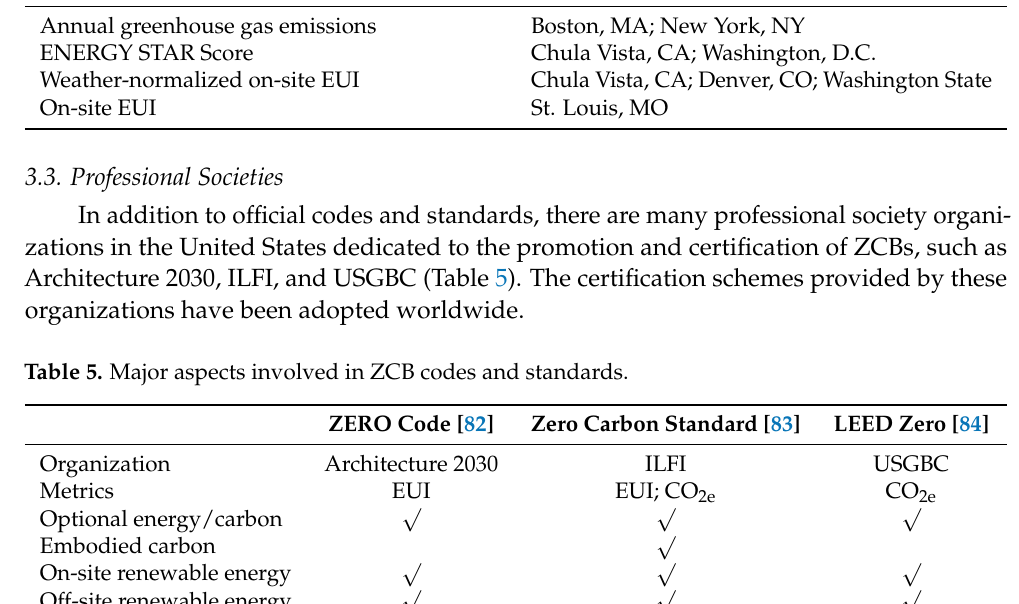
Table 4. Different types of building metrics used by some local governments (adapted from [81]). Criteria